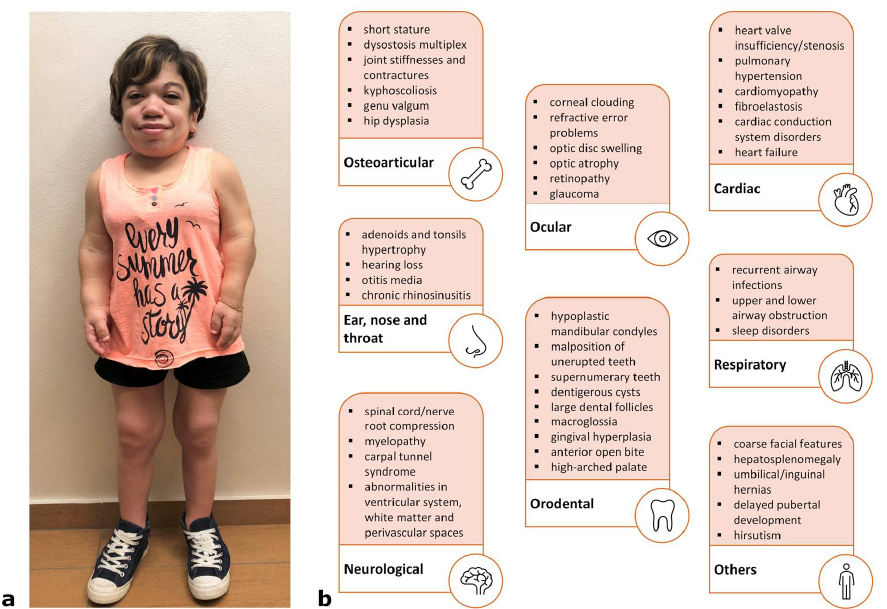
Figure 3. ( a ) A 20-year-old female MPS VI patient, showing facial dysmorphism, short stature and claw hands; ( b ) main clinical manifestations associated with the